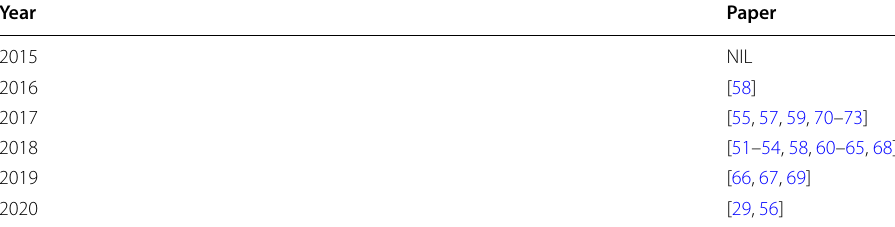
Table 3 Analysis based on year of publication